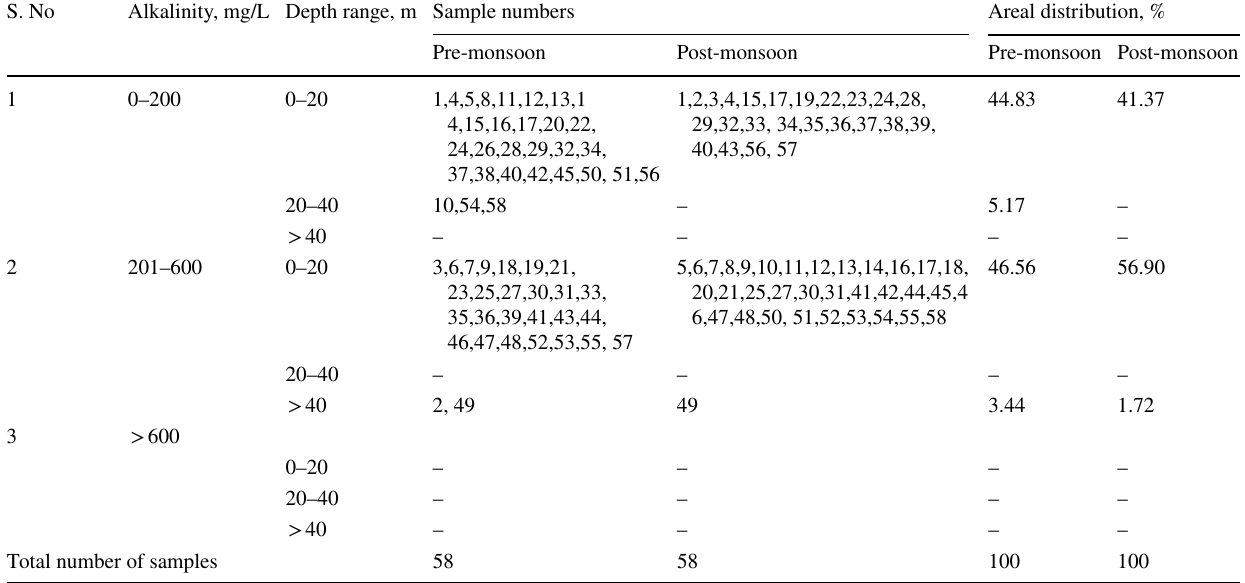
Table 5 Alkalinity distribution in groundwater of the study area S. No Alkalinity, mg/L Depth range, m Sample